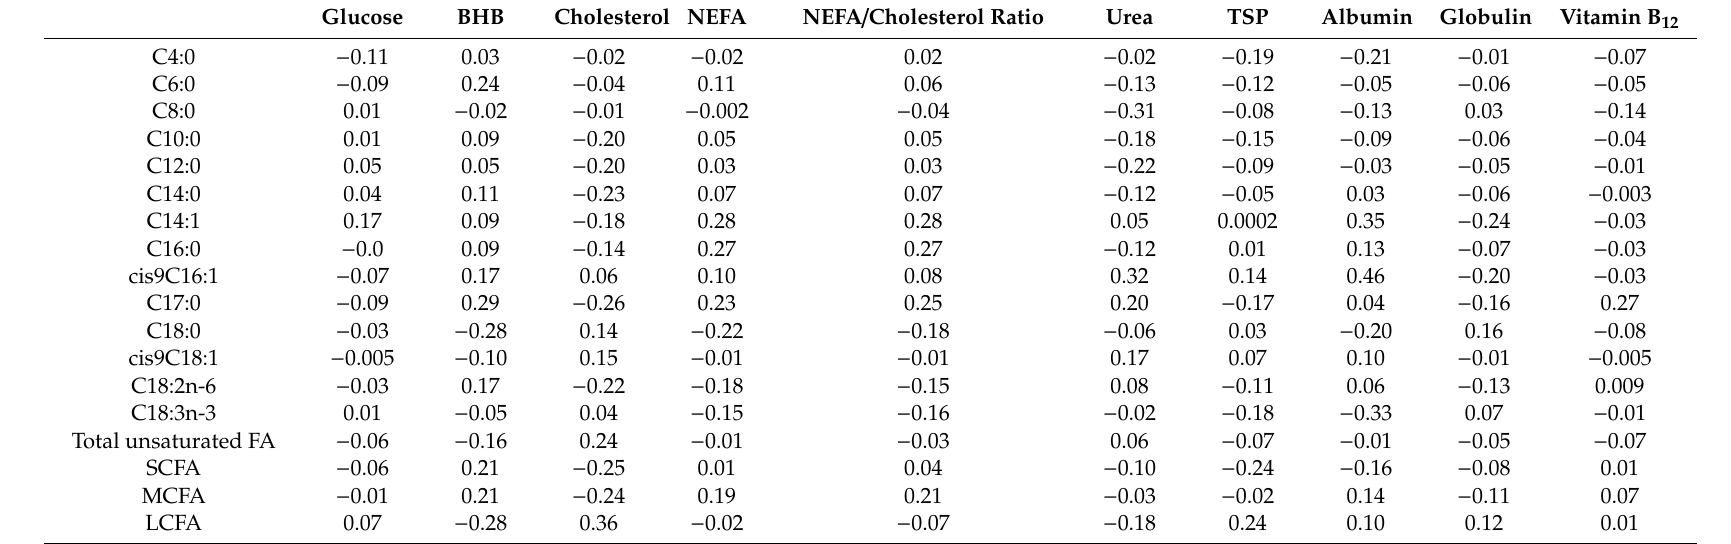
Table A2. Pearson’s correlations between fatty acids (FA) and blood metabolites at di ff erent periods after parturition: weeks + 1 (A), + 2 (B) and + 3 (C), respectively. A. Pearson’s correlations at week + 1 relative to